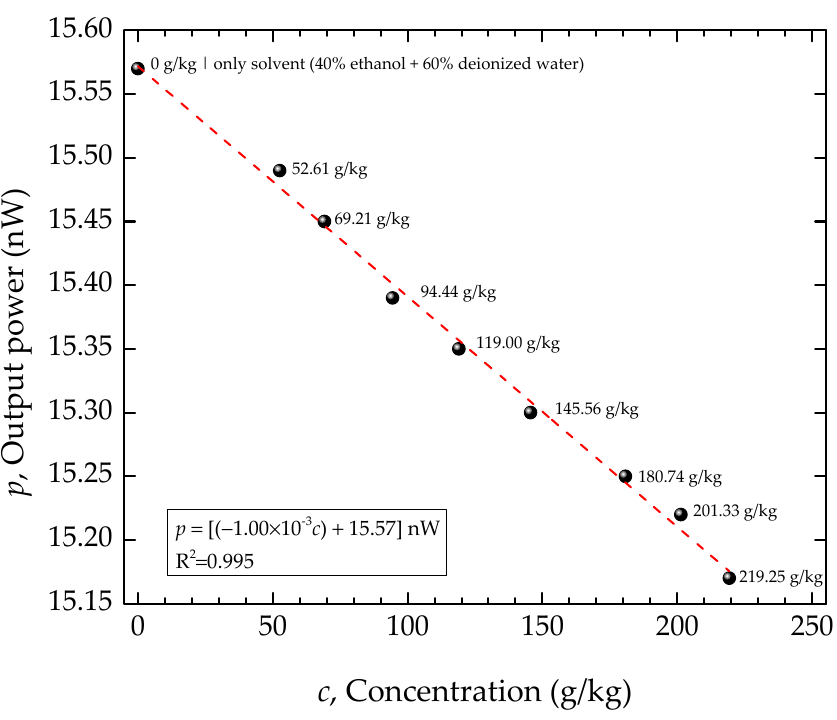
Figure 6. Output power levels as a function of paracetamol concentration in solution when the end of the reference port was immersed in the reference solution (40% ethanol and 60% deionized water) and sensing head was immersed in the paracetamol